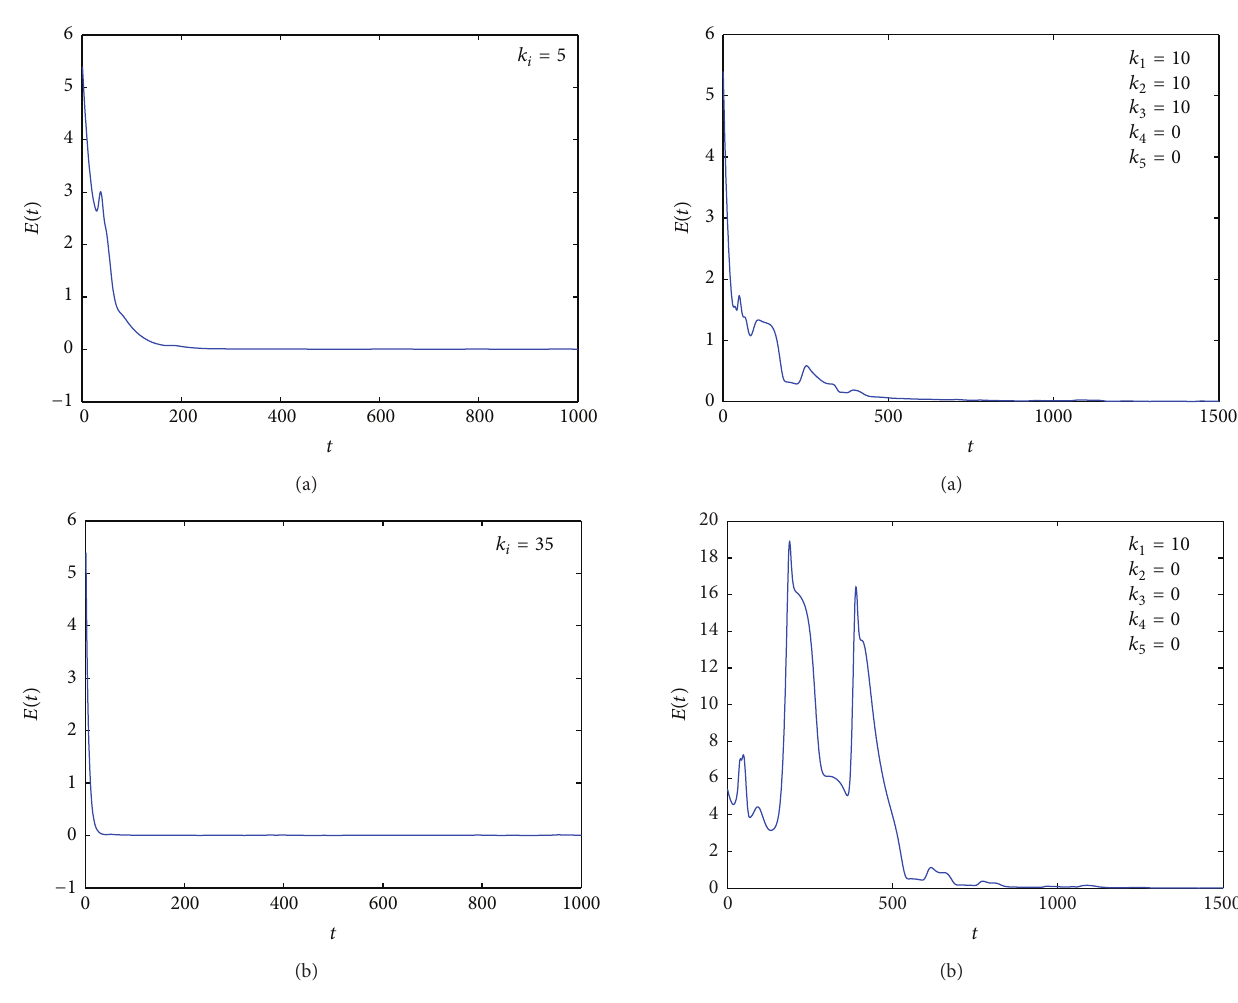
Figure 5: Time evolutions of synchronization error 𝐸(𝑡) with different values of 𝑘 𝑖 .